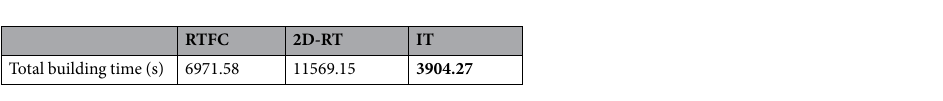
Table 5. The total building time (in seconds) of the three tree structures on ENCODE genomic intervals for the 23 chromosomes. Abbreviations: RTFC = range tree with fractional cascading; 2D-RT = basic 2-dimensional range tree; IT = interval